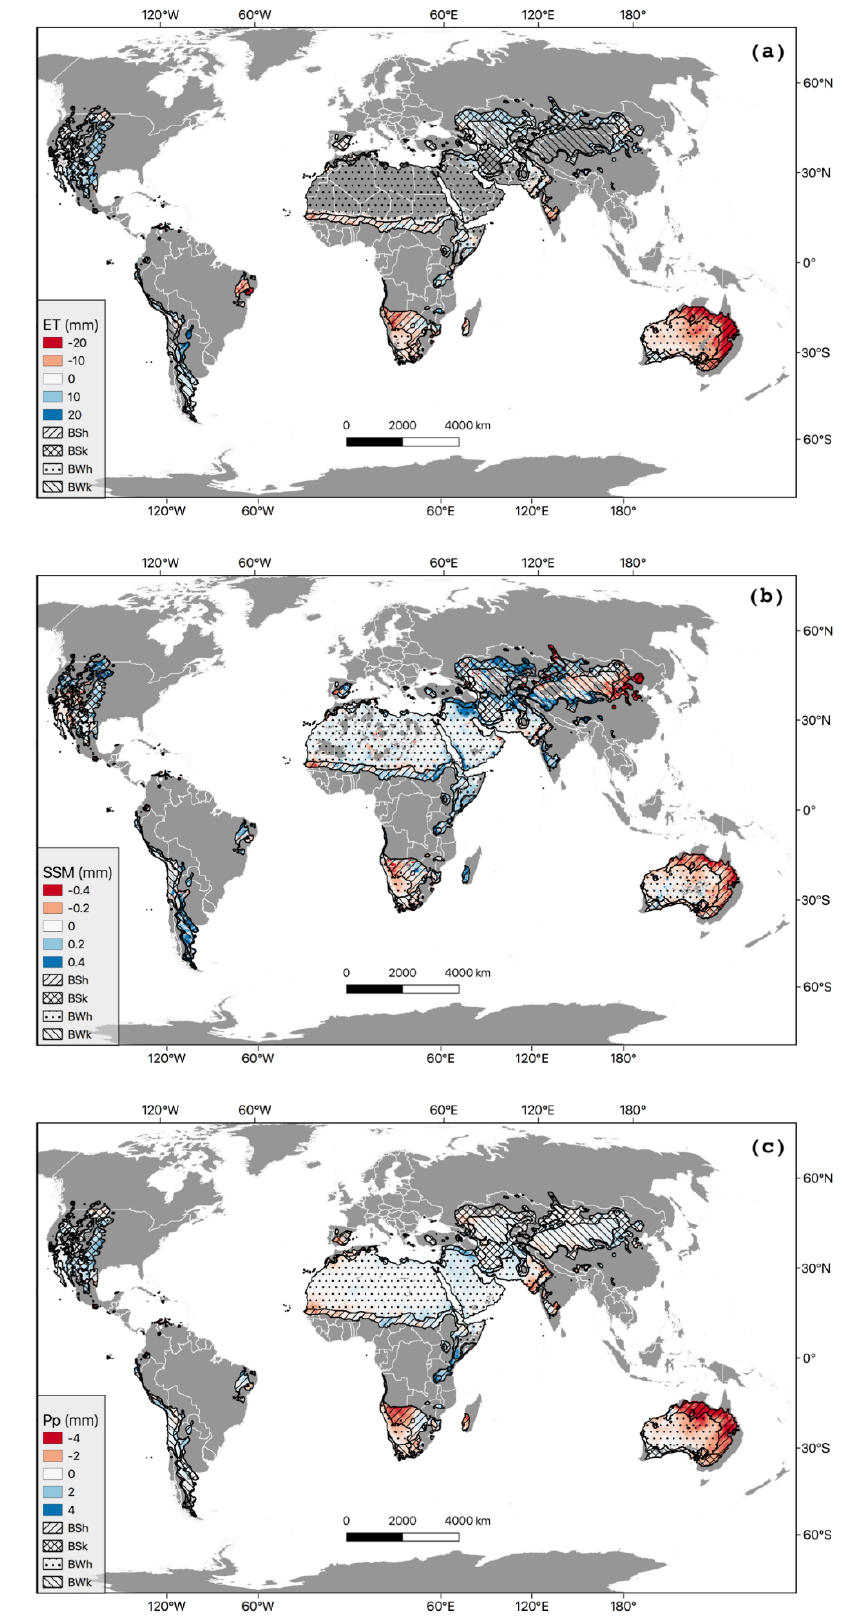
Figure 6. Yearly trends followed by multiple hydrological factors ( a ) evapotranspiration (ET), ( b ) surface soil moisture and ( c ) precipitation over the arid region are calculated based on harmonic analysis of the periods between the years 2010–2019. Only regions with a confidence level of 95% are shown .